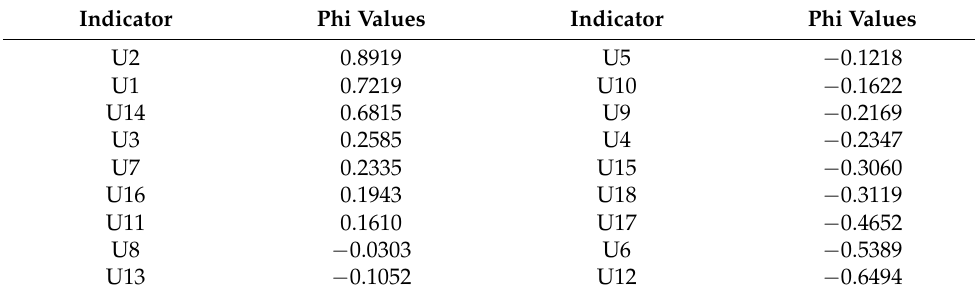
Table 11. PROMETHEE II results for user aspect in healthcare facilities.